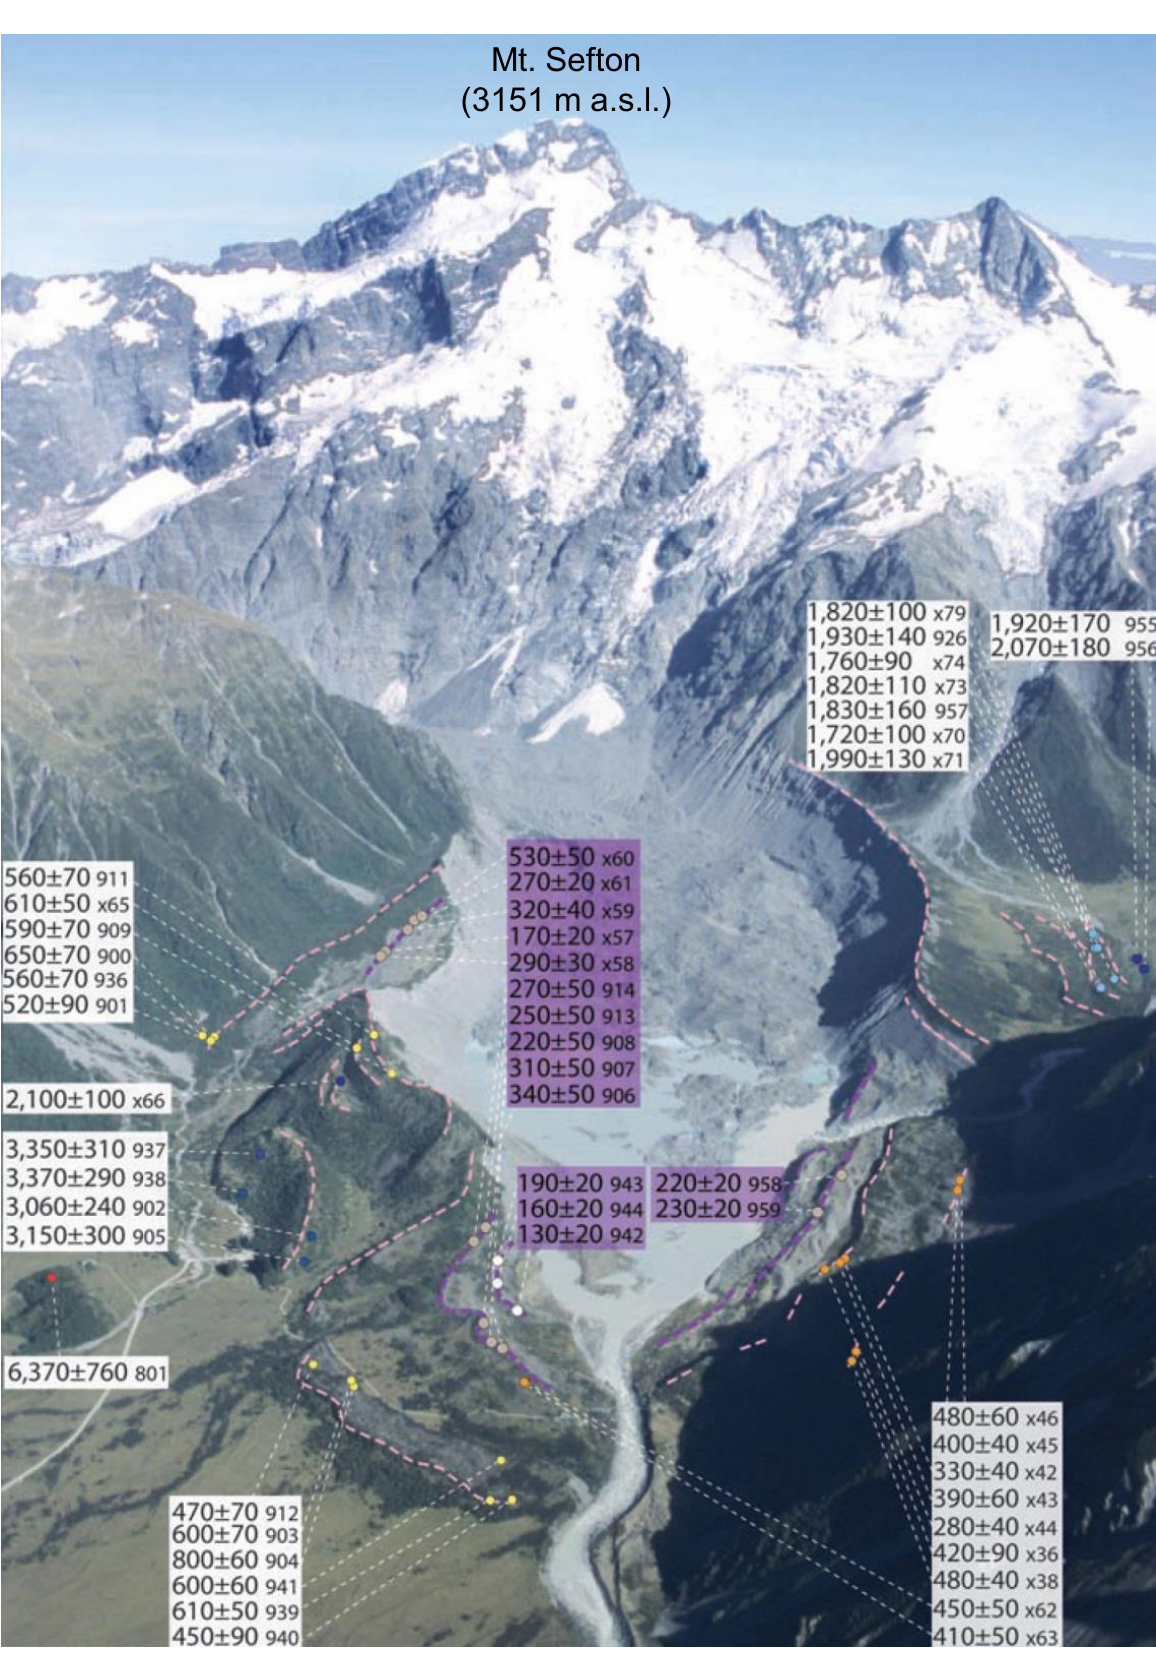
Figure 8. This figure is reproduced from Ref. [16] and shows the results of the 10 Be ages (given in years with 2σ uncertainties) with the assignment to the Holocene moraines of the Mueller glacier. The ages marked in purple colour are from moraines which were deposited during mid- to late-19 th